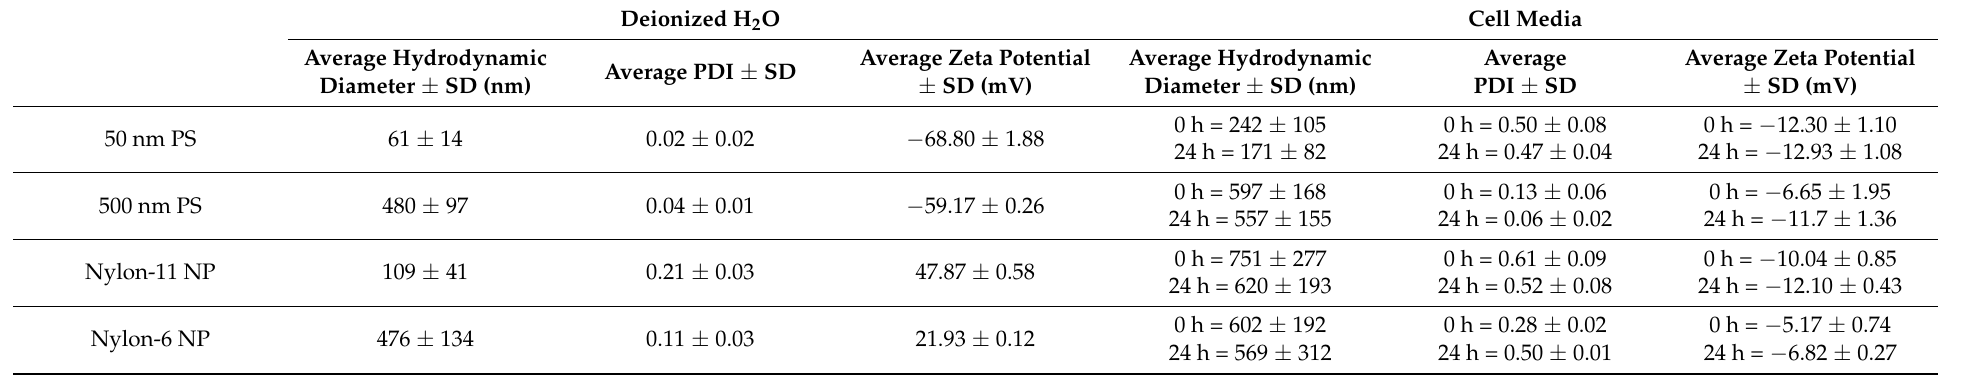
Table 2. Hydrodynamic diameter, PDI, and zeta potential in water and cell media for particles used in cell exposure